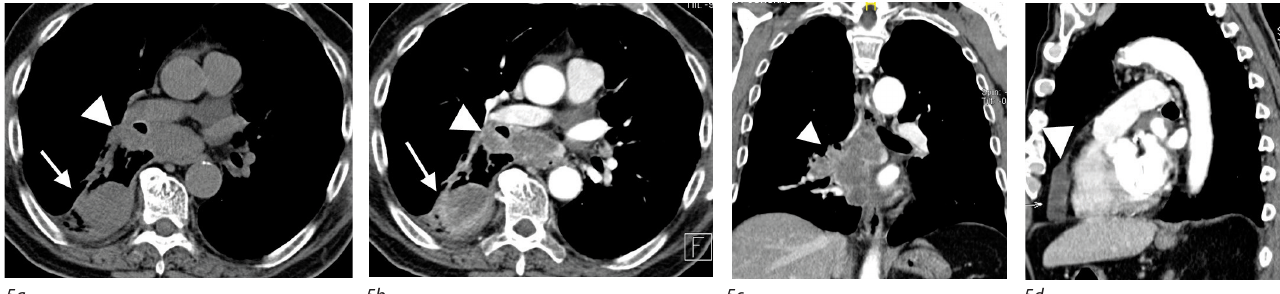
5a 5b 5c 5d Fig. 5. There is a carcinoma mass in the right lung (arrows in precontrast 5a and post-contrast 5b scans) with peripheral enhancement of the mass. Infiltrated lymph nodes show typical peripheral enhancement on the post-contrast series (arrowheads in 5b, 5c and 5d).